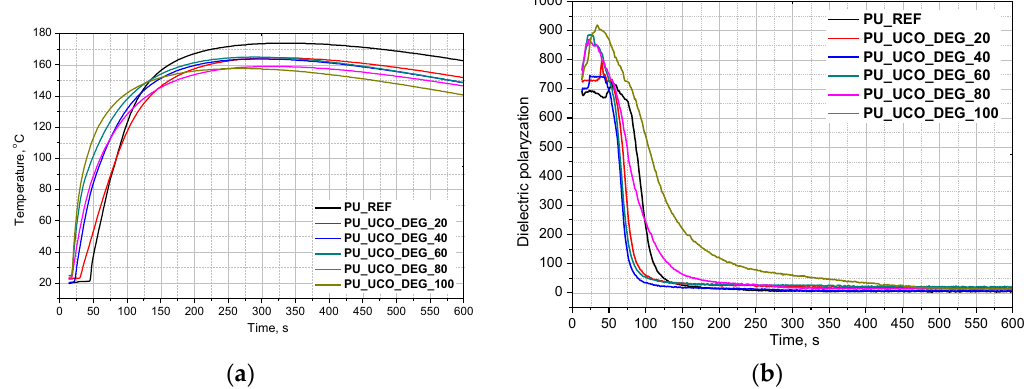
Figure 3. Foams core temperature profiles ( a ) and dielectric polarization changes in time ( b ) during foaming process of PUR system based on UCO_DEG.